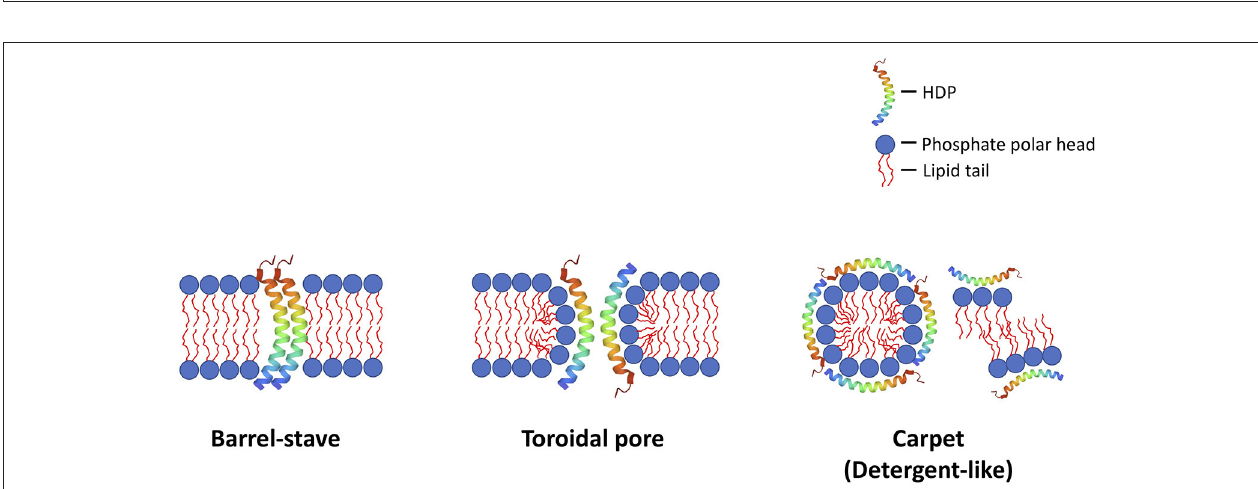
FIGURE 2 | Illustrations of the common membrane-permeabilizing mechanisms of host defense peptides (HDPs) against bacteria (and other microbes), namely: (1) barrel-stave; (2) toroidal pore; and (3) carpet (detergent-like) mechanisms. In the barrel-stave model, the HDPs act as a stave and penetrate vertically into the negatively charged, lipid bilayer bacterial membrane, creating permanent “barrel-shaped” pores. In the toroidal pore model, the HDPs interact with the negatively charged phosphate head groups electrostatically, distort the arrangement of the lipid bilayer, and create a transient membrane pore, with HDPs lining and stabilizing the internal part of the pore. In the carpet (detergent-like) model, the HDPs interact with the bacterial membrane electrostatically, and, upon reaching the critical concentration on the bacterial membrane, they result in membrane fragmentation / aggregation. These mechanisms result in destabilization of the membrane integrity, which leads to influx of fluid and efflux of intracellular content, culminating in cell lysis. Although less common (not shown in this figure), HDPs may also exert their antimicrobial action via binding to microbial intracellular targets (i.e., non-membrane-permeabilizing mechanisms), inhibiting DNA/RNA synthesis, protein synthesis and protein